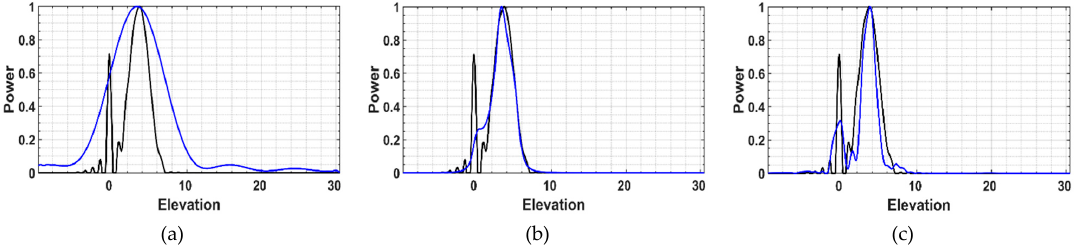
Figure 2. Extracted span profiles of the simulated scenario with full-rank reconstruction of T , ( a ) Beamforming, ( b ) Capon, ( c ) the proposed method. Blue and black indicate the reconstructed and simulated signals.